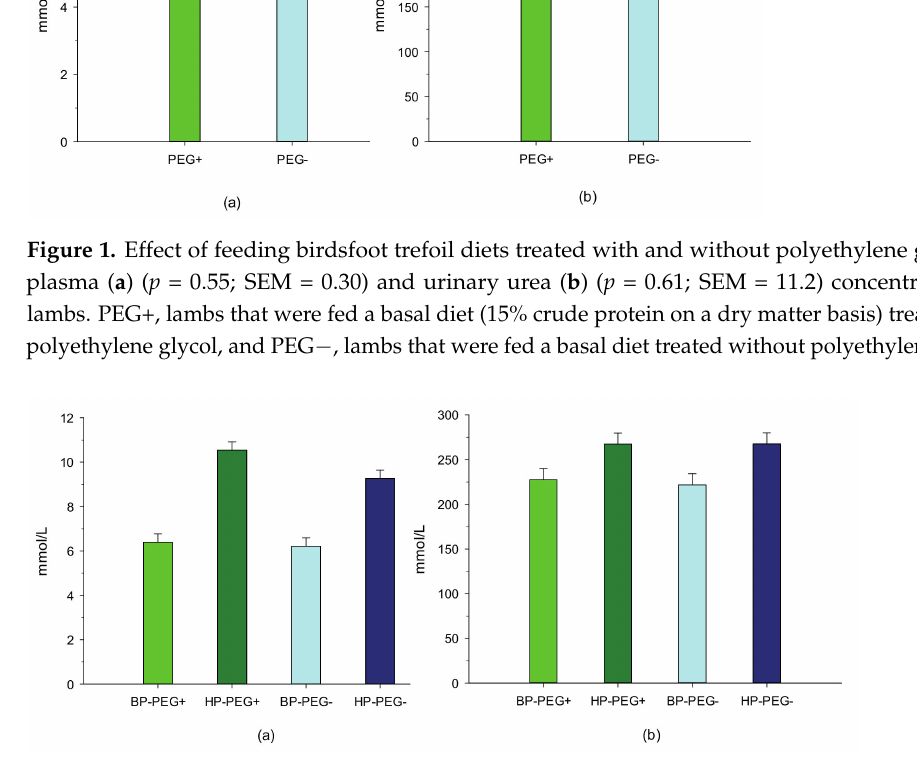
Figure 2. Effect of birdsfoot trefoil diets varying in crude protein level and treated with and without polyethylene glycol on plasma ( a ) ( p = 0.16; SEM = 0.37) and urinary urea ( b ) ( p = 0.82; SEM = 12.3) concentrations of lambs. BP-PEG+, lambs that were fed a basal diet (15% crude protein on a dry matter basis) treated with polyethylene glycol; HP-PEG+, lambs that were fed a high protein diet supplemented with soybean meal concentrate (20% crude protein on a dry matter basis) and treated with polyethylene glycol; BPPEG − , lambs that were fed a basal diet treated without polyethylene glycol; and HPPEG − , lambs that were fed a high protein diet supplemented with soybean meal concentrate and treated without polyethylene